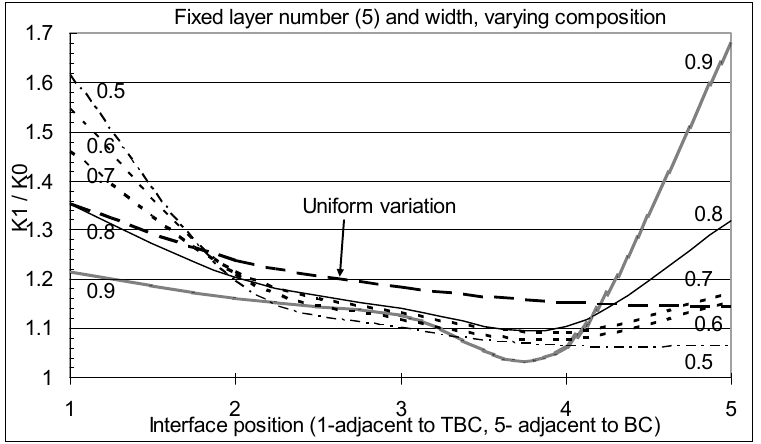
Figure 13. Effect of different layer width (fraction of total TBC width) on K 1 / K 0 for 5-layer FGM.